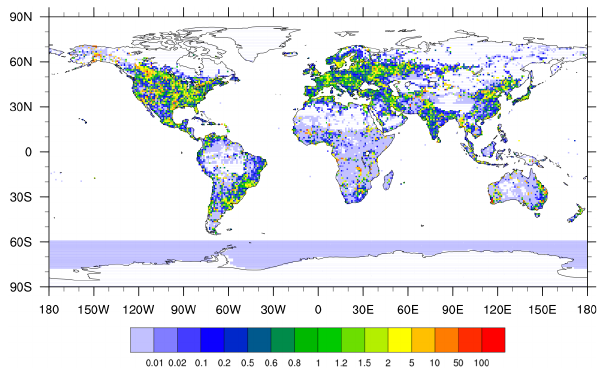
Fig. 5. The global distribution of emission ratio between our inventory (power plant data plus nightlight-based) and the CDIAC gridded inventory (population-based) for the year 2006. The emission ratio (our inventory divided by CDIAC) is calculated using our inventory (reduced to 1 ◦ × 1 ◦ resolution from 5 km × 5 km resolution) and the CDIAC 1 ◦ × 1 ◦ gridded inventory (Andres et al., 2009). The calculated emission ratios are plotted with the range of 0.01 (1/100) and 100 (100 times). An emission ratio of 1 indicates that emissions of our inventory and CDIAC are identical, and ratios larger than 1 indicate that our inventory overestimates the CDIAC inventory, and vice versa. The regions with no color (white) indicate zero emission for both inventories. Emission pixels of our inventory with zero CDIAC emissions were not included in this analysis.